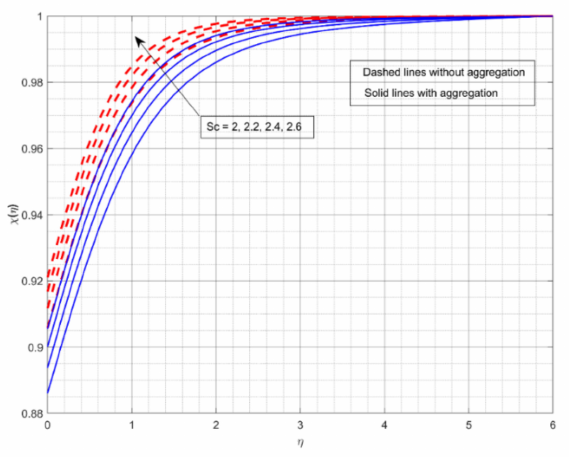
Figure 10. The impact of Schmidt number on the concentration profile χ ( η )